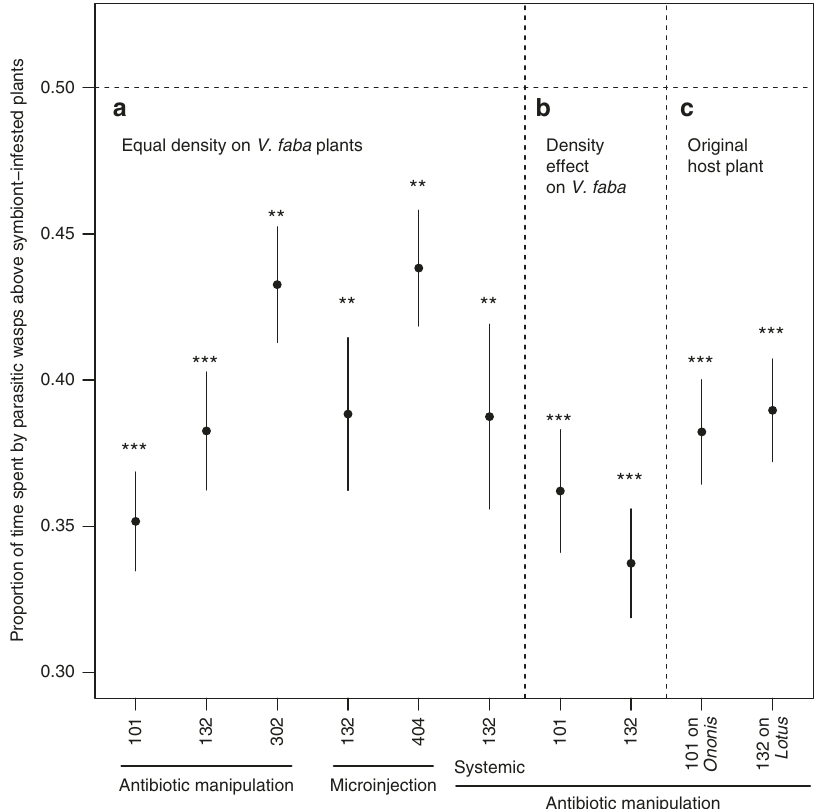
Fig. 1 Parasitic wasp preference for volatiles from Fabaceae plants infested with aphids with or without the endosymbiont. Parasitic wasp ( Aphidius ervi ) response to volatiles emitted by plants infested with aphids ( Acyrthosiphon pisum ) with or without the endosymbiont Hamiltonella defensa . For each test, the bars show standard errors and the asterisks the signi fi cance of the deviation from no choice ( t -test: ** p < 0.01; *** p < 0.001). a Tests where Vicia faba plants had been induced by 20 wingless aphid females each ( n = 10; column i — cured 101: t 9 = − 8.78, p < 0.0001; ii — cured 132: t 9 = − 5.82, p = 0.0001; iii